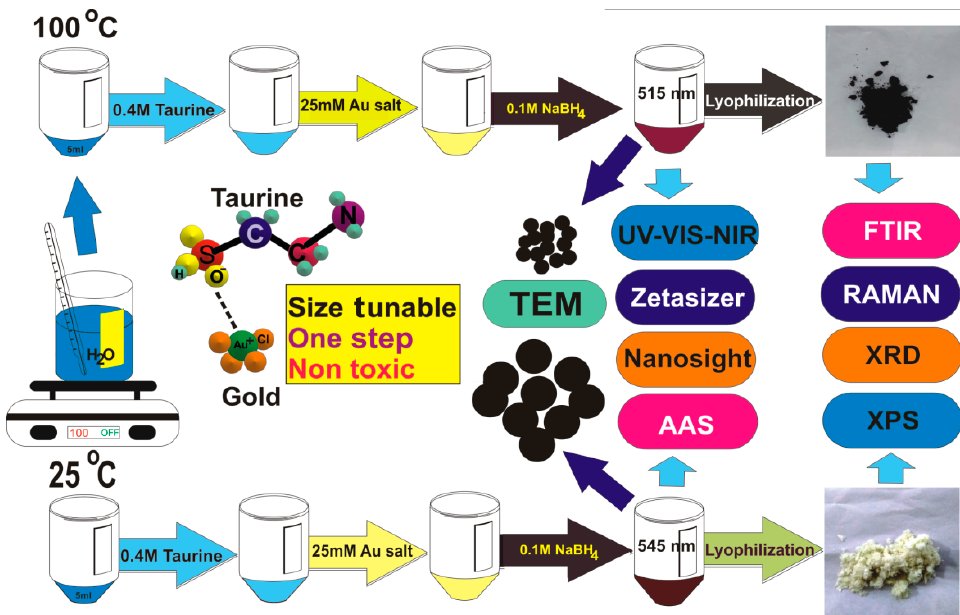
Figure 1. Schematic diagram of the taurine-capped gold nanospheres that were synthesized with a wet-chemical method in a one-step / one-pot method. The reaction parameters controlled the morphology and size of the taurine-capped gold nanospheres, both of which were dependent on temperature. The absorption bands of the di ff erent sizes of gold nanospheres were 515 nm and 545 nm, and these were dependent on their size. Detailed characterizations of the taurine-capped gold nanospheres were done by using various standard techniques to determine their absorbance, size, shape, charge, surface composition, binding energy and crystalline structure. The taurine-capped gold nanospheres were obtained both in solution and nanopowder form with a high yield and